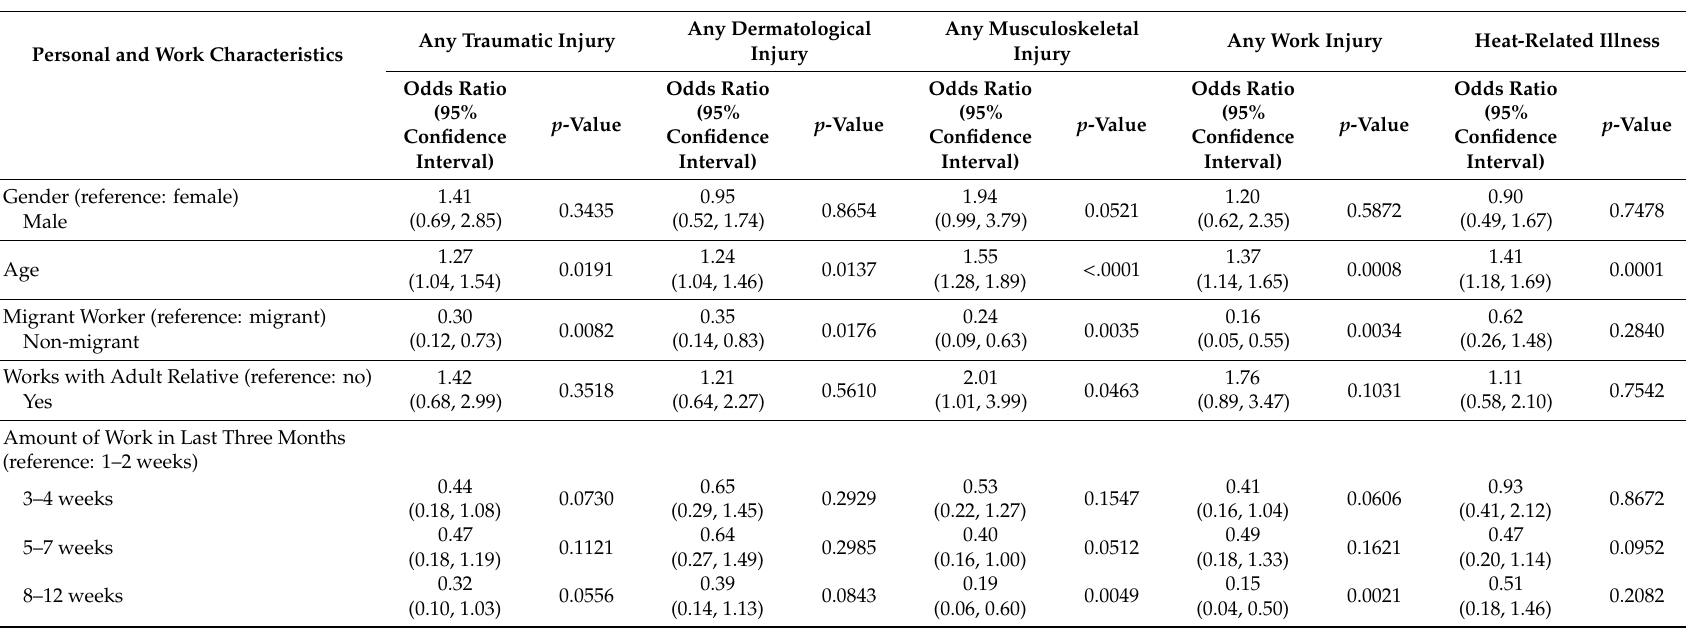
Table 7. Logistic regression analysis of personal and work characteristics with occupational injuries in the past year for North Carolina Latinx child farmworkers, 2017. Personal and Work